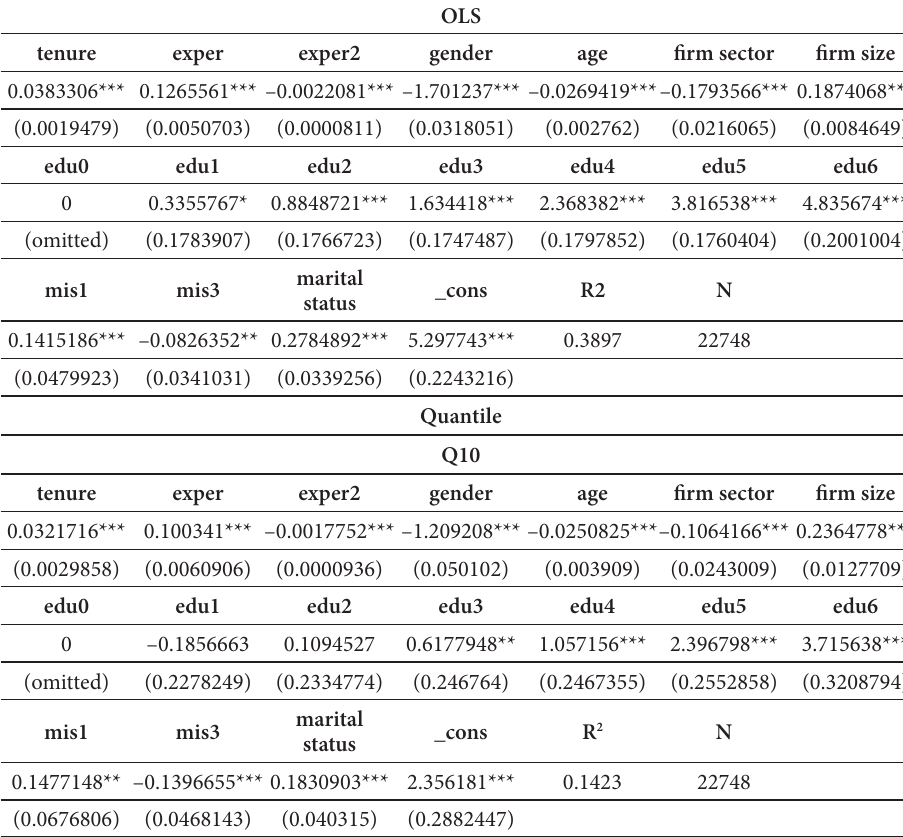
Table 4. OLS and quantile